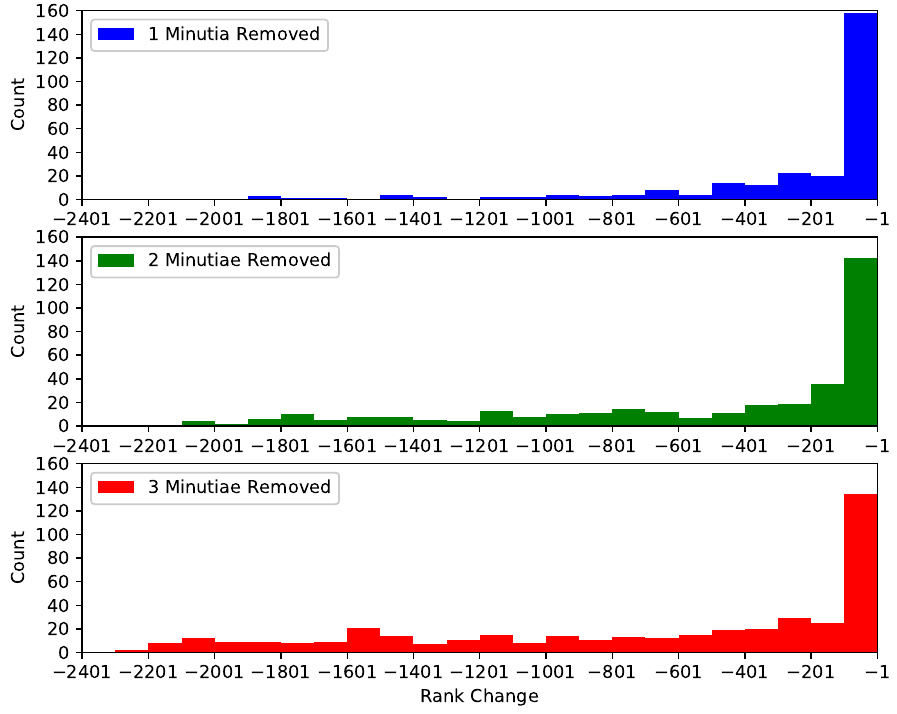
Figure 9. Histogram of rank loss for “lower” class regarding